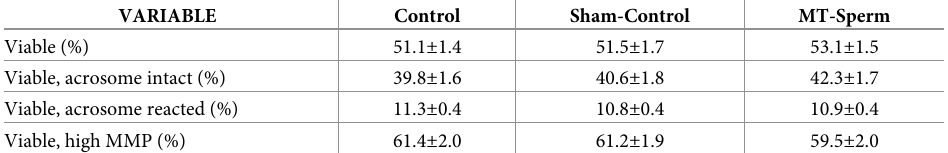
Values are LS means ± SEM based on semen samples from 4 different bulls and three replicates each for semen assessment. Values from different incubation times, i.e. 30 min, 120 min, and 180 minutes have been combined according to the experimental groups. Control: without any supplements. Sham-Control: Ethanol in the sperm preparation medium. MT-Sperm: Melatonin in the sperm preparation medium. High MMP: high mitochondria membrane potential. No statistically significant differences with respect to the factors treatment or incubation time were observed ( P > 0.05).